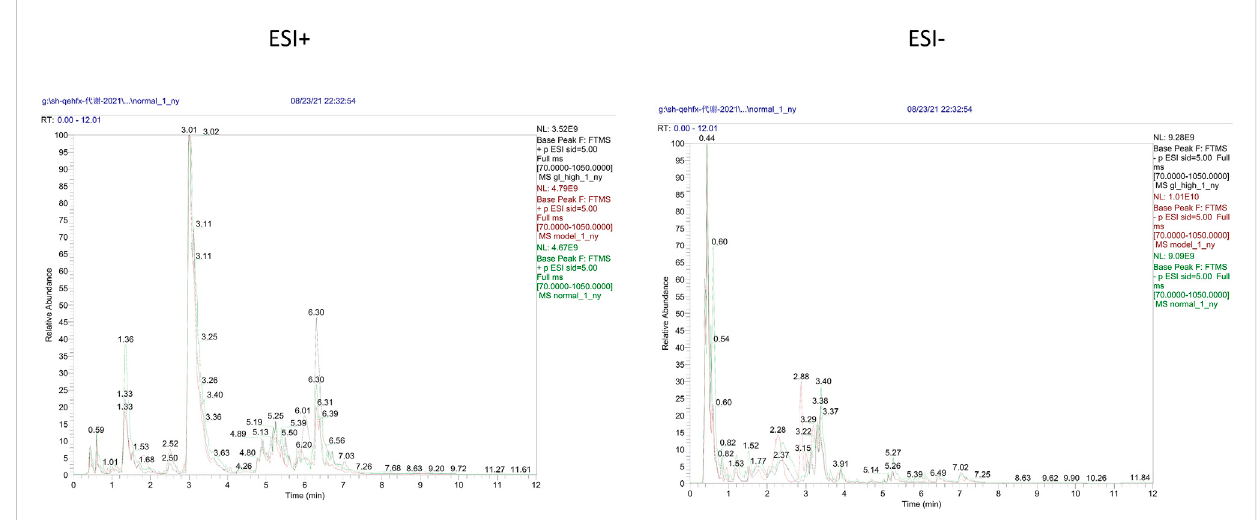
FIGURE 6 Representative BPC of rat Serum in positive and negative ion mode for each